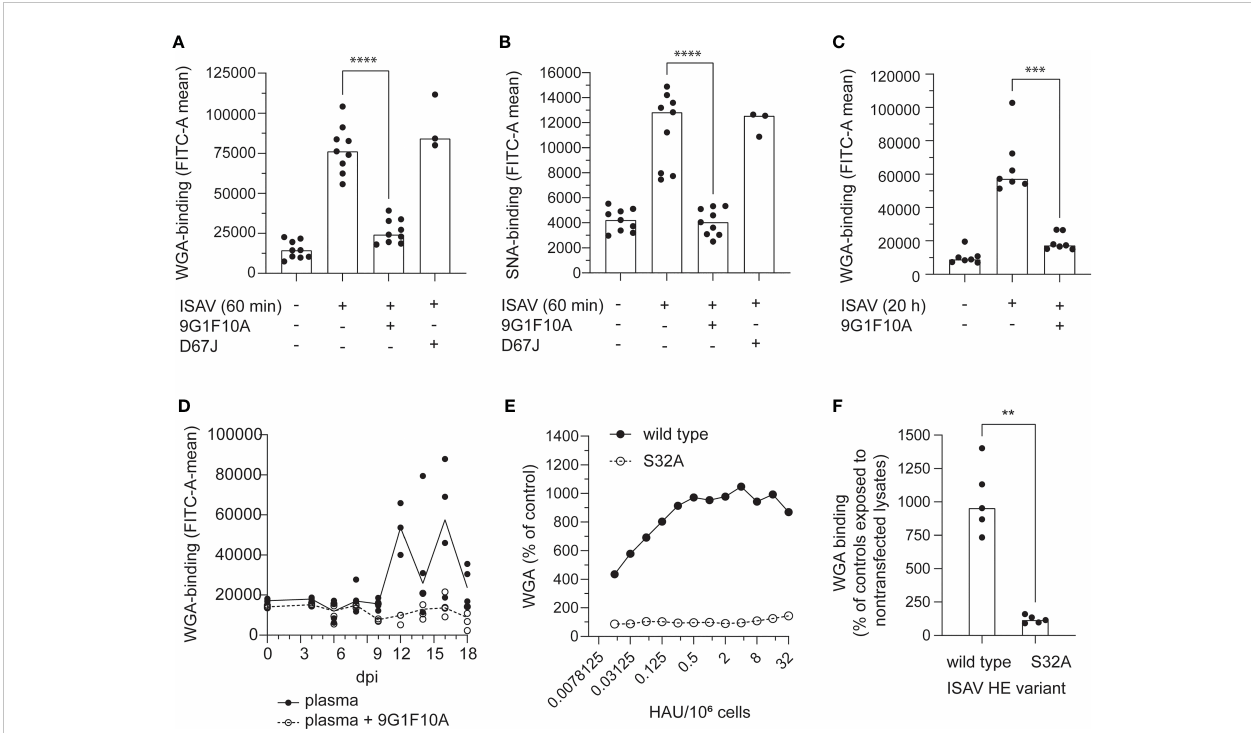
FIGURE 5 The pruning of erythrocyte surface is mediated by the ISAV esterase. (A – C) Virus supernatants were pre-incubated with antibodies targeting HE (9G1F10A) or the in fl uenza A virus nucleoprotein (D67J) as a negative control (both: 5 µg/mL, 30 min, RT) before inoculation with erythrocytes ( A-B : 10 6 TCID 50 per 20 million cells, 60 min; C : 10 5 TCID 50 per 20 million cells, 20 hours). Flow cytometry was used to evaluate (A, C) WGA-binding and (B) SNA-binding. (D) Plasma from infected fi sh harvested at the indicated time points was added to erythrocytes (10 µL/10 6 cells) either alone (black dots and line) or pre-incubated with the antibody 9G1F10A (open circles, stippled line). Samples were incubated overnight before quanti fi cation of WGA- binding by fl ow cytometry. Data points show cells incubated with plasma from individual fi sh (4 per time point). The lines connect medians. (E, F) WGA-binding to erythrocytes exposed to wild type or esterase-silenced (S32A) HE at 1 HAU per 10 6 cells for 20 hours. (A-D, F) Each data point represents blood cells isolated from one fi sh. Bars and line show median values. **p < 0.01, ***p < 0.001, ****p < 0.0001, Mann Whitney